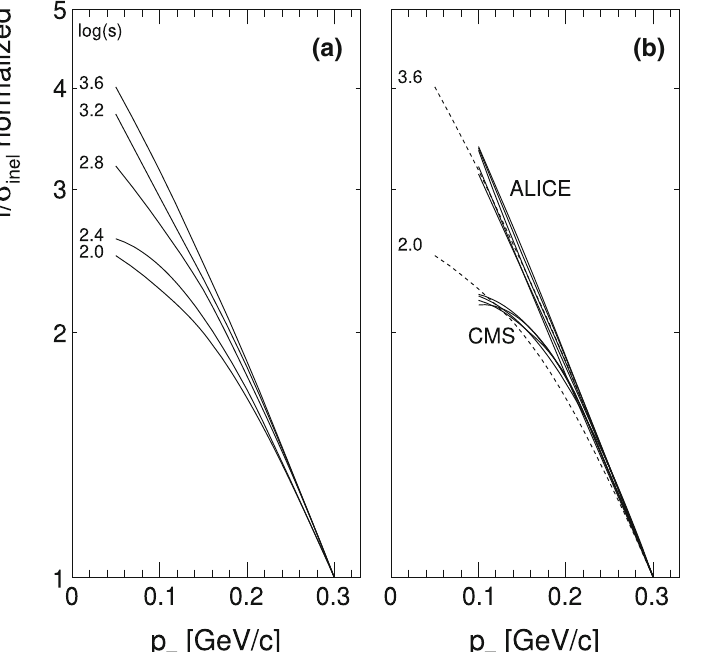
√ s = 10 GeV to 63 GeV/c. The data are normalized to 1 at